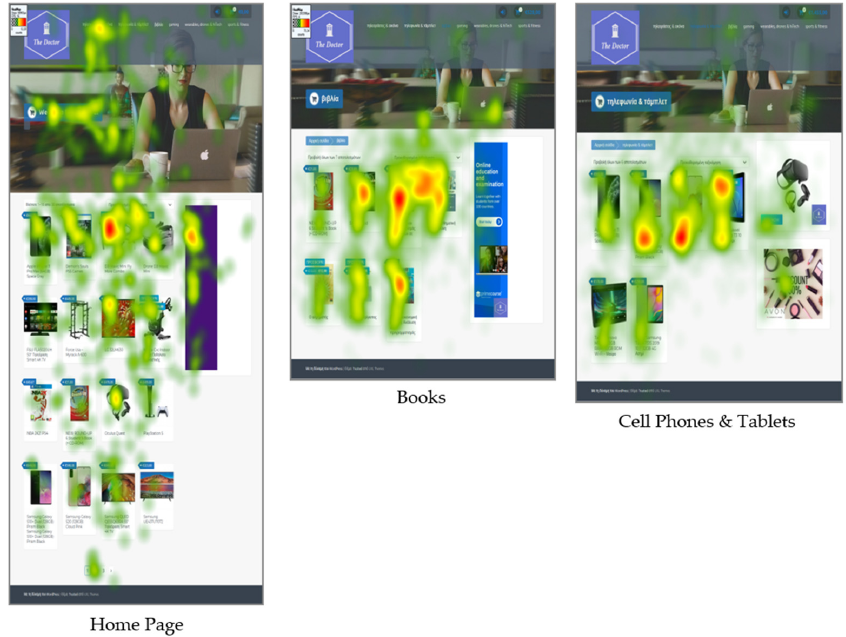
Figure 4. Heatmaps of banner advertisements with irrelevant content.